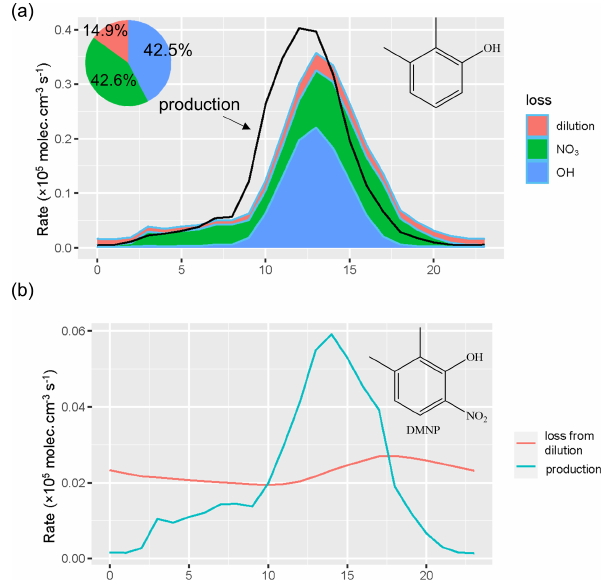
Figure 6. Production and loss of xylenol (a) and DMNP (b) during the sampling